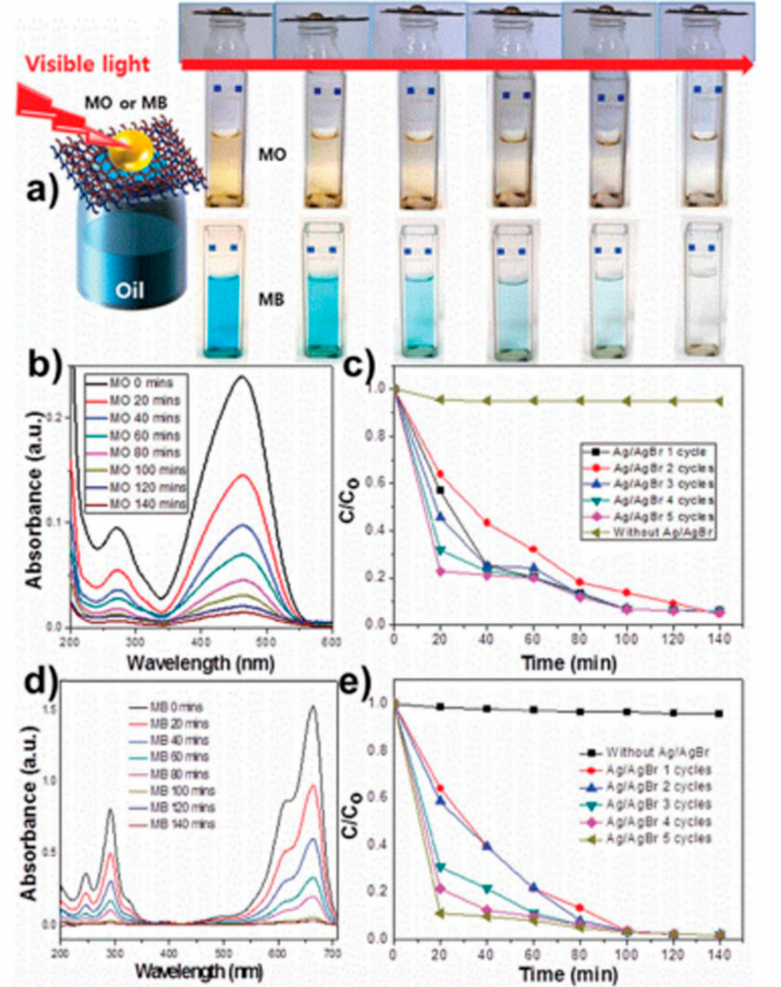
Figure 9. ( a ) Photocatalytic decomposition process demonstrating the purification of methylene orange (MO) and methylene blue (MB). Double-layer Cu meshes consisting of a photocatalytic mesh (Cu mesh / Pdop / Ag / AgBr) and a superhydrophobic mesh (Cu mesh / 1H,1H,2H,2H-perfluorooctyltriethoxysilane (PFTOS)) were used for the test. The degradations of ( b ) MO and ( d ) MB catalyzed by a photocatalytic mesh under visible-light irradiation. The reuse test data of a photocatalytic mesh under visible-light irradiation for ( c ) MO and ( e ) MB up to 5 cycles. Reproduced with permission from [167]. Copyright 2016 The Royal Society of